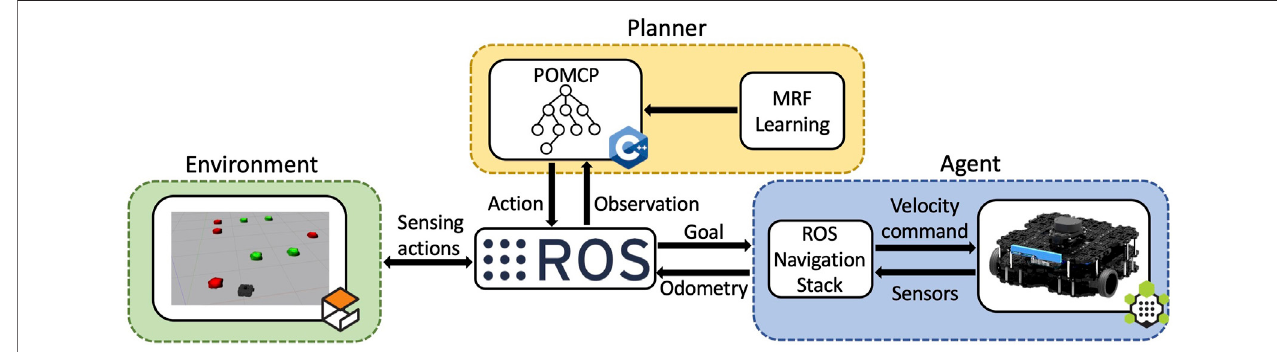
FIGURE 2 | ROS architecture for running POMCP on mobile robotic platforms. The three main components are identi fi ed by the colored boxes and connected to the same ROS network. The planner supports standard POMCP, extended POMCP, and our proposed approach with MRF adaptation, besides the MRF learning